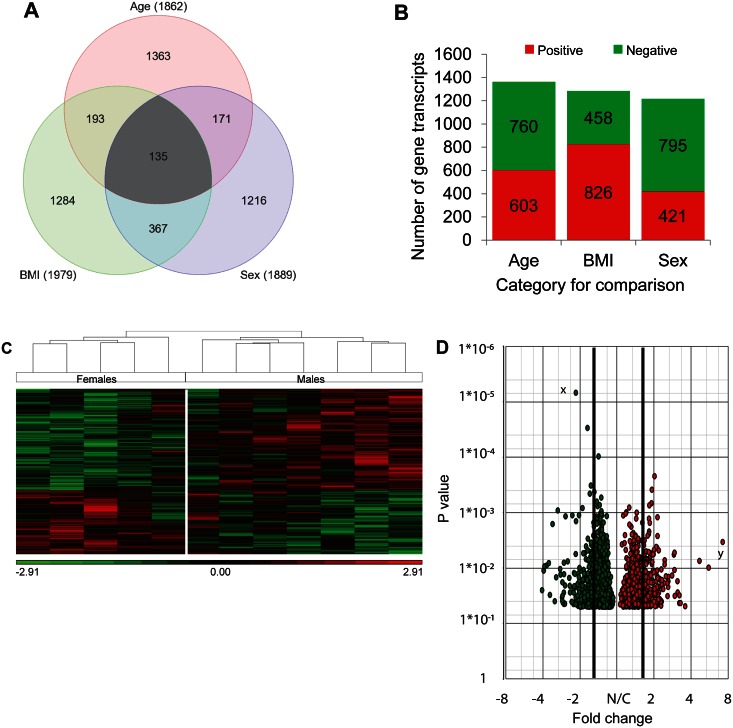
Pictorial representation of microarray data.Microarray analysis of human healthy articular cartilage was conducted to assess the effect of age, BMI, and sex. A. Venn diagrams represent the number of differentially expressed genes in each comparison. Values in parentheses are the numbers of differentially expressed genes. Values in overlapping areas are the numbers of genes common to any two comparisons. B. Numbers of differentially expressed gene transcripts across all three factors are shown. Number of gene transcripts shown for age and BMI indicate positively (red) and negatively (green) correlated gene transcripts while for sex they represent up-regulated (red) and down-regulated (green) gene transcripts in females versus males. C. Hierarchical clustering map, representing the transcripts that were significantly (P<0.05) differentially expressed between the two sexes is shown. Each vertical row depicts a single sample, and each horizontal line stands for a single gene transcript. Green color indicates down-regulated gene transcripts while red color indicates up-regulated gene transcripts. D. The differentially expressed gene transcripts at all fold changes are shown in the form of volcano plots to show the trend of expression by P value (y axes) and fold change (x axes). Gene transcripts outside the thick black lines are those that have ≥1.5 fold expression x = gene transcripts with lowest P value (statistically highly significant) y = gene transcripts with highest fold change (biologically highly significant), green circles = gene transcripts down-regulated in females, red circles = gene transcripts up-regulated in females, N/C = no change.